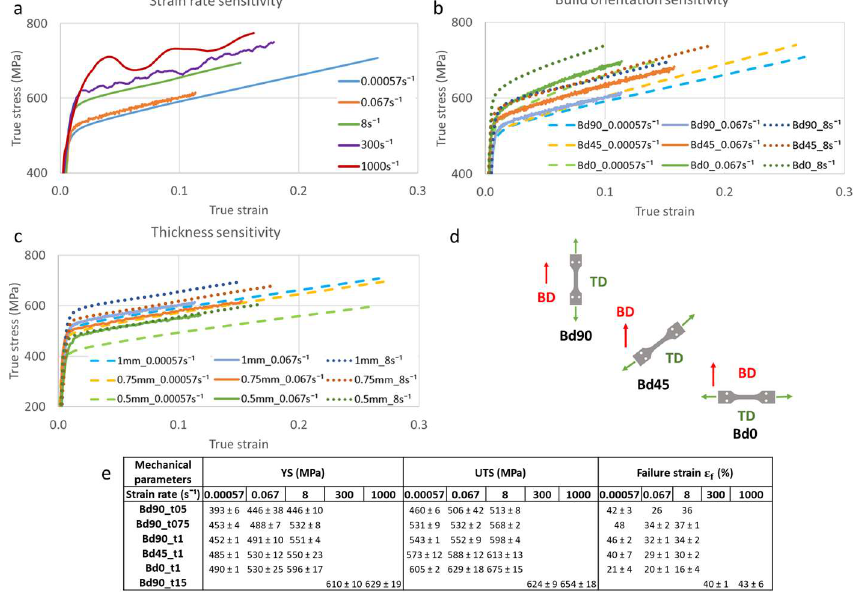
Fig. 1. True stress-strain curves of strain rate sensitivity of vertical samples (a), building orientation sensitivity of 1mm thick samples (b), thickness sensitivity of vertical samples (c) and a representation of the three building orientations along the Tensile Direction (TD) and the Building Direction (BD). Conventional mechanical parameters of all configurations